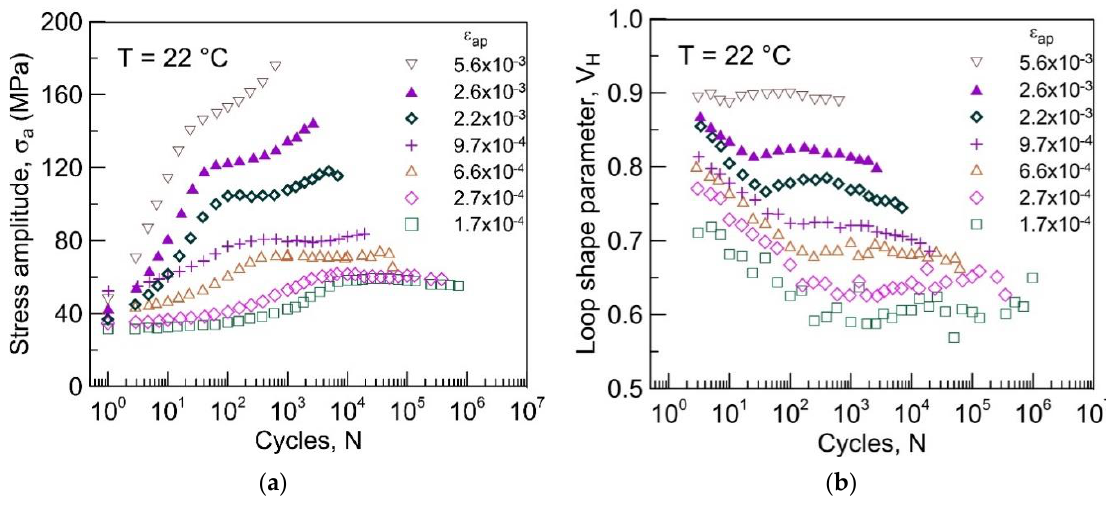
Figure 9. Stress-strain response of polycrystalline copper in constant plastic strain amplitude loading; ( a ) stress amplitude vs. number of cycles, ( b ) loop shape parameter vs. number of cycles.